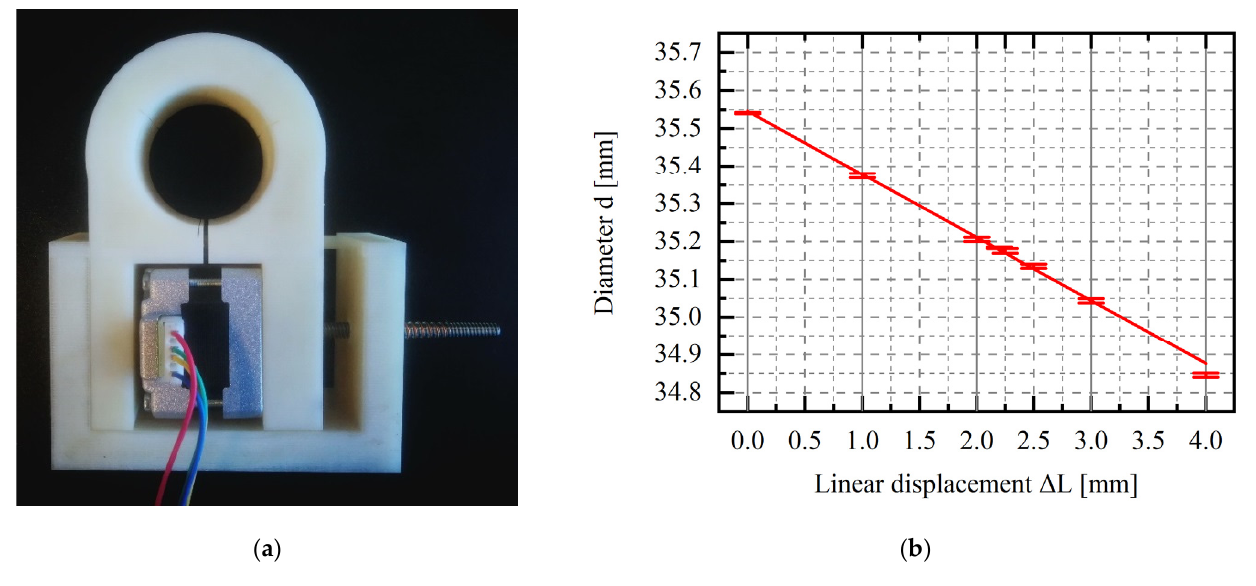
Figure 2. ( a ) The prototype of the active bearing was made using 3D printing ( b ) and sample results of preliminary research: diameter versus linear displacement of the stepper motor (designated by M); the initial value of L = 35.14 mm.